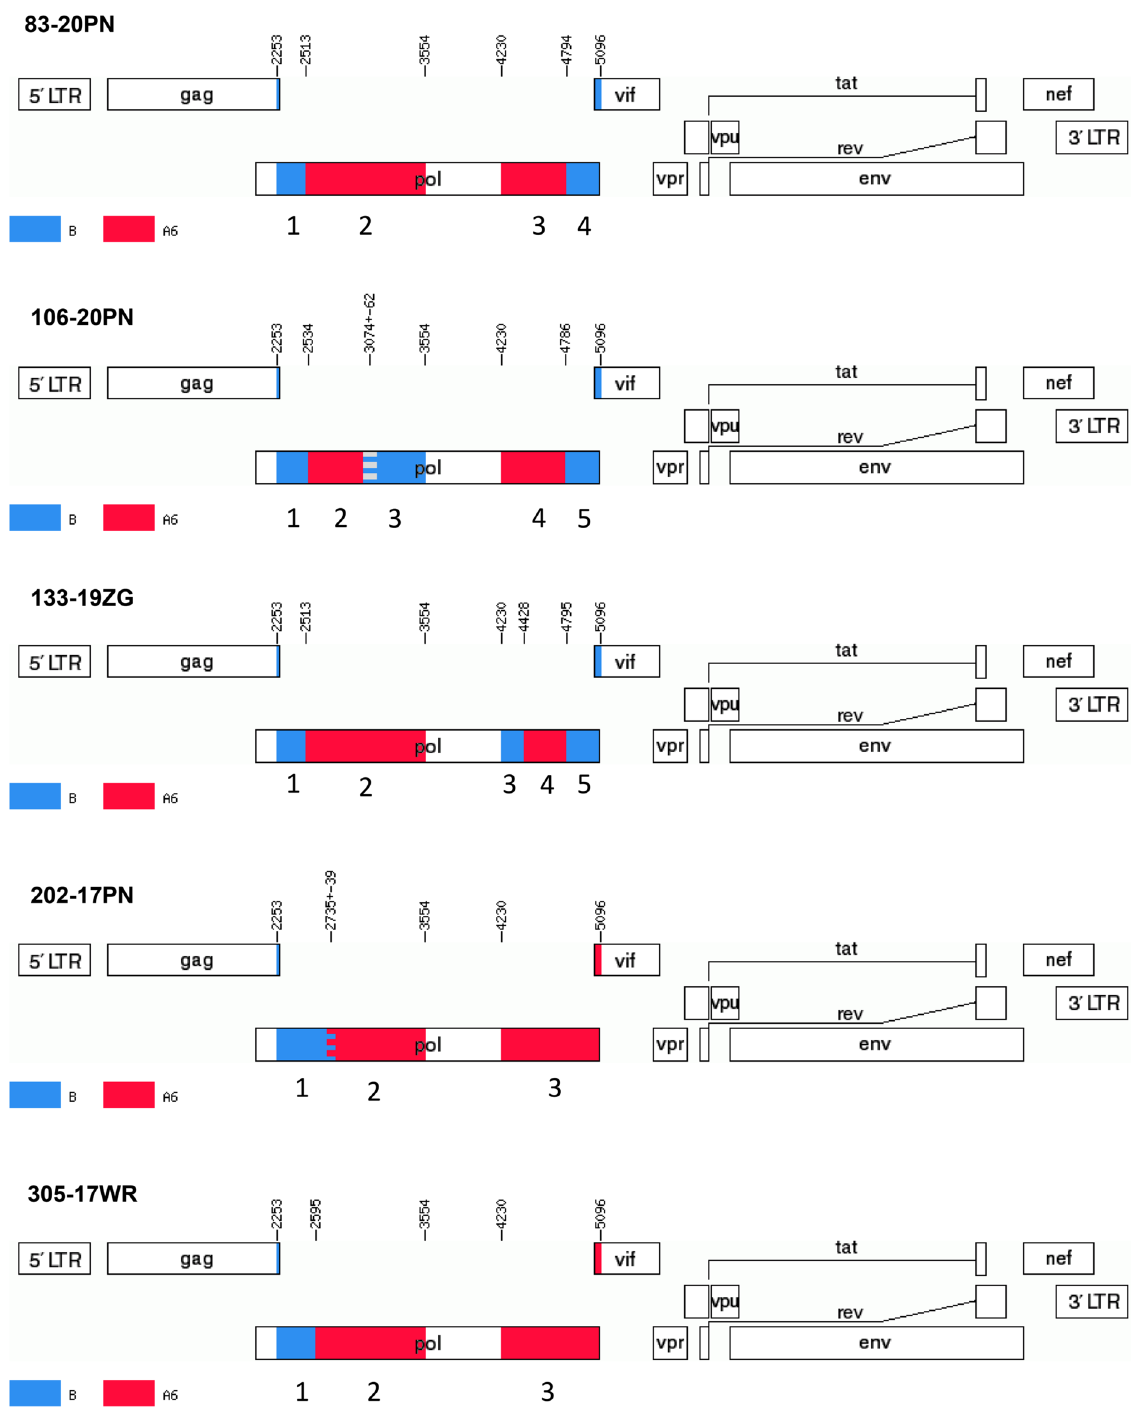
Figure 5. Recombination pattern of the five partial HIV-1 pol sequences from the identified A6B Cluster 1. Analysed region include the protease with a fragment of the reverse transcriptase gene (2253–3554 bp) and the integrase gene (4230–5096 bp). Recombination breakpoints (according to HXB2 genome positions) were obtained using Simplot v3.5.1 software and jumping-profile hidden Markov model (jpHMM). The blue color stands for HIV-1 subtype B, red color stands for sub-subtype A6. Component subtype regions are labeled from 1 up to 5 on the genome map, corresponding with numbered on phylogenetic trees in Supplementary Figure S3. The mosaic map was generated using the Recombinant HIV-1 Drawing Tool (https:// www. hiv. lanl. gov/ conte nt/ seque nce/ DRAW_ CRF/ recom_ mapper.